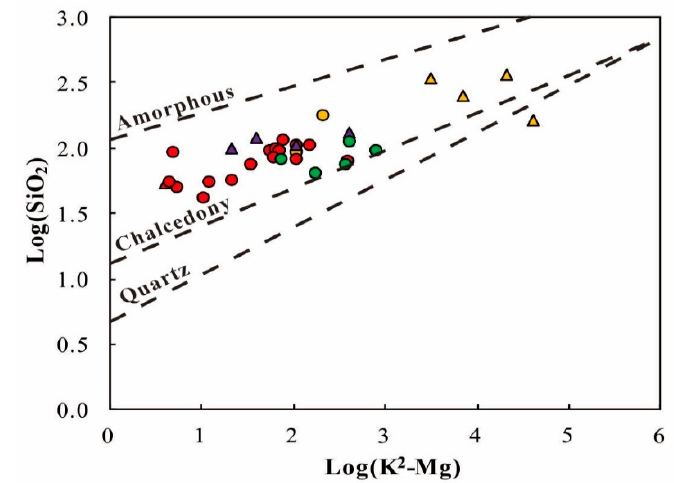
Figure 8. Cross plots of log (K 2 /Mg) vs. log(SiO 2 ) of the geothermal waters in the XFZ [29]. Legends follow those in Figure